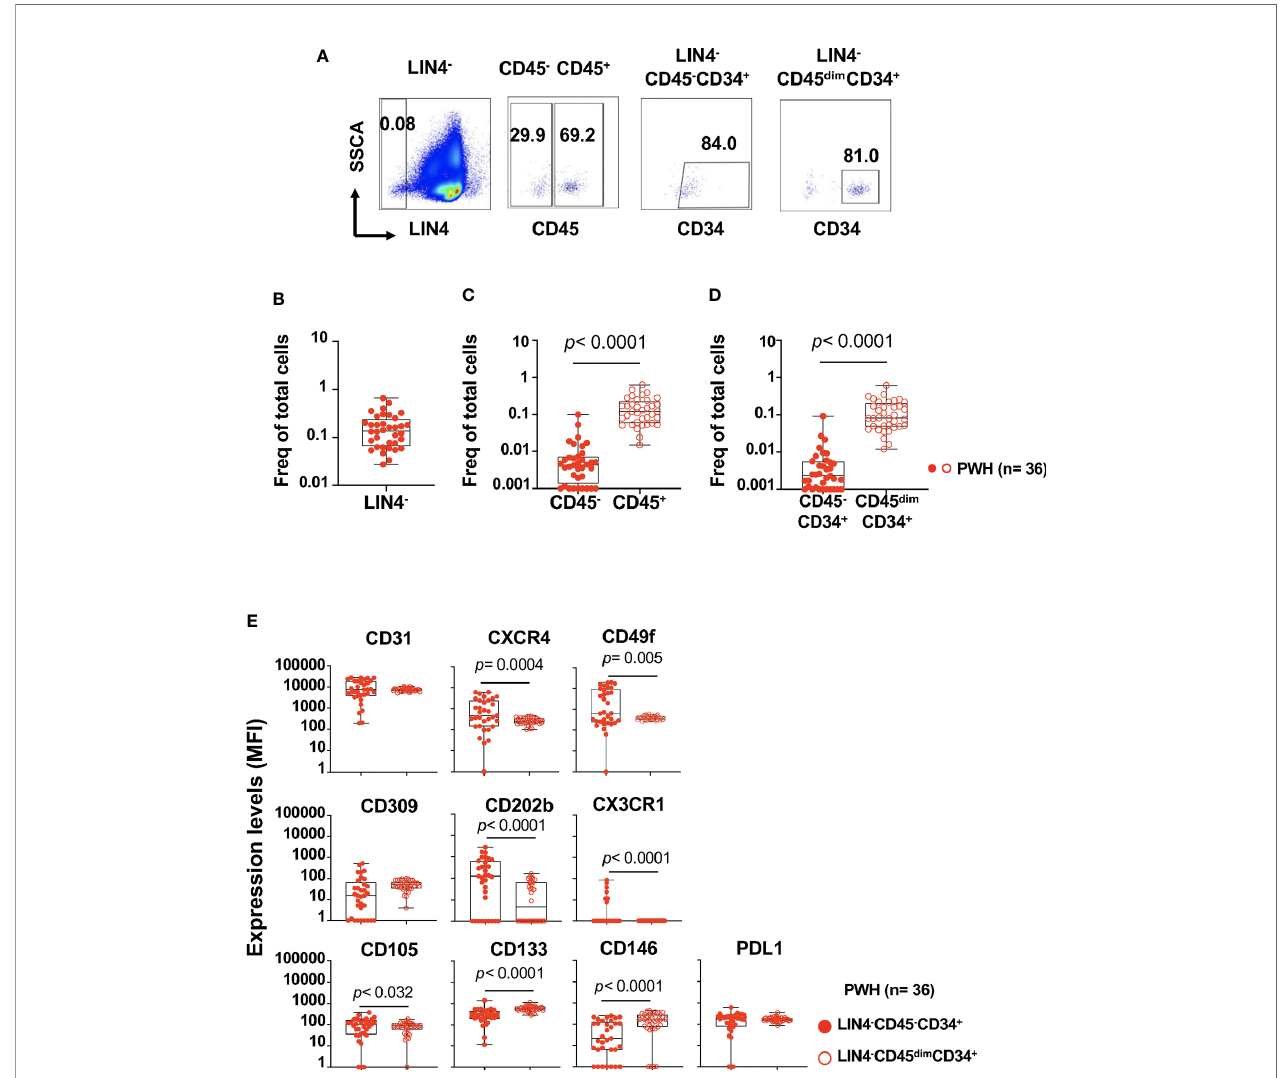
FIGURE 1 | Detection and phenotype of two circulating cell progenitors LIN4 - CD45 - CD34 + and LIN4 - CD45 dim CD34 + in PBMCs from PWH. PBMCs from PWH (n= 36) were thawed and rested overnight. PBMCs were stained with LIVE/DEAD followed by a cocktail of mAbs: LIN4, CD45, CD3, CD8, CD34, CD31,CD105, CD49f, CD133, CD146, PDL-1, CD14, CD309 and CD202b ( Supplementary Table S2 ). Full minus one (FMO) was used control. (A) Representative dot plots of the gating strategy. Frequency of: (B) LIN4 - , (C) LIN4 - CD45 - and LIN4 - CD45 + , (D) LIN4 - CD45 - CD34 + and LIN4 - CD45 dim CD34 + cells are represented as the frequency of total live cells. (E) Expression of the markers CD31, CXCR4, CD49f, CD309, CD202b, CX3CR1, CD105, CD133, CD146 and PD-L1 in the LIN4 - CD45 - CD34 + (closed red circle) and LIN4 - CD45 dim CD34 + (open red circle) cells are shown as median fl uorescence intensity (MFI). Whiskers represent median and IQR. Comparison between subsets was performed using non-parametric Wilcoxon test. P value < 0.05 was considered signi fi